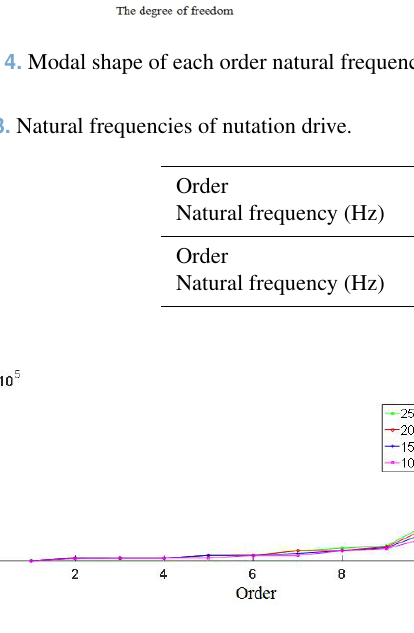
Figure 5. Natural frequency with different average meshing stiff- ness.